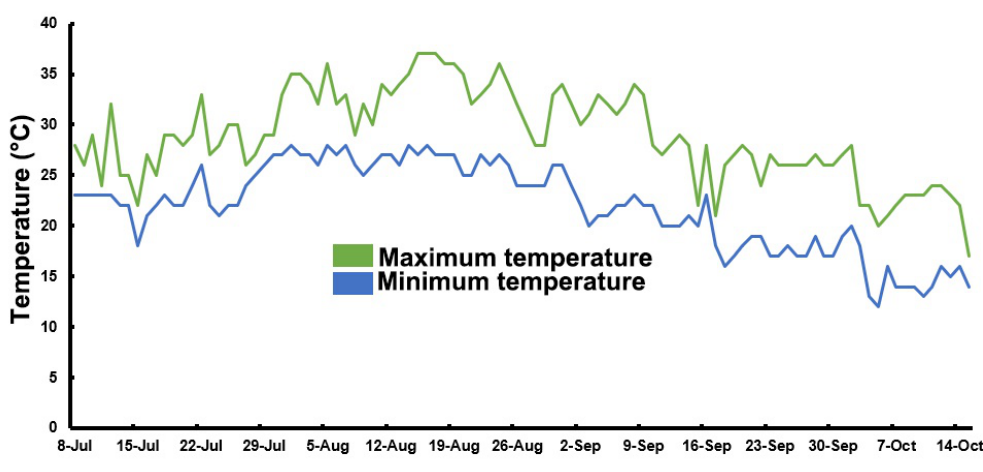
Figure 10. During rice planting, the field daily maximum and minimum temperature.